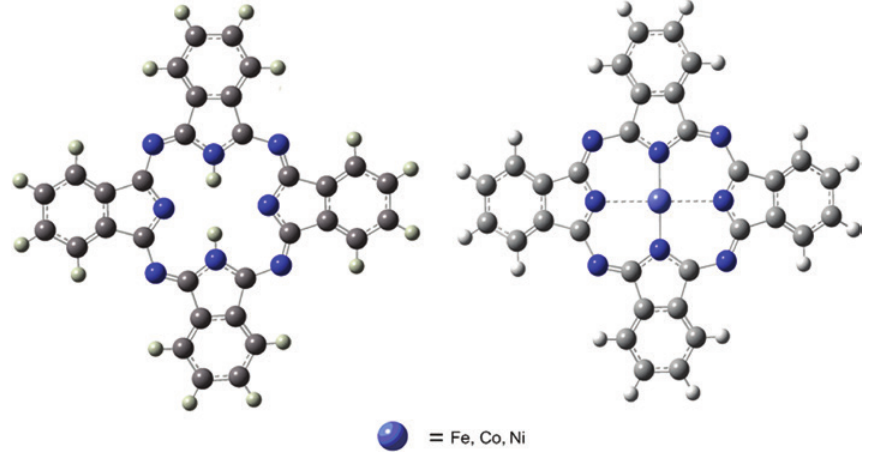
Figure 1: The structure of phthalocyanine and metal-phthalocyanine complexes.